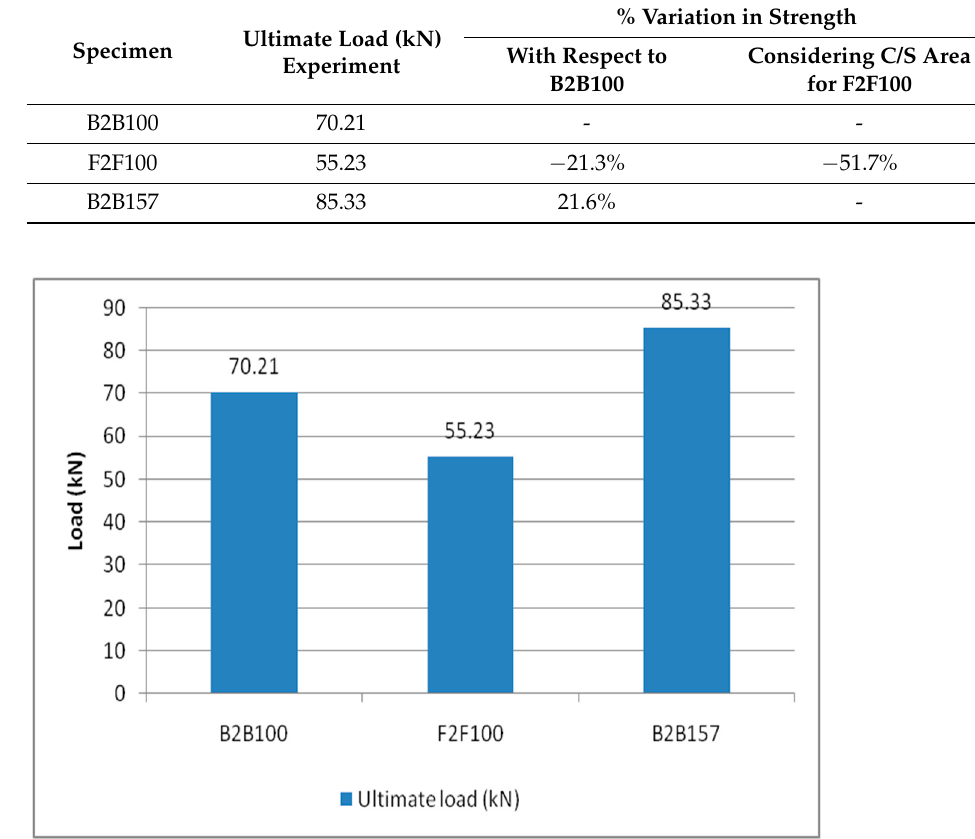
Figure 14. Ultimate load carrying capacity.